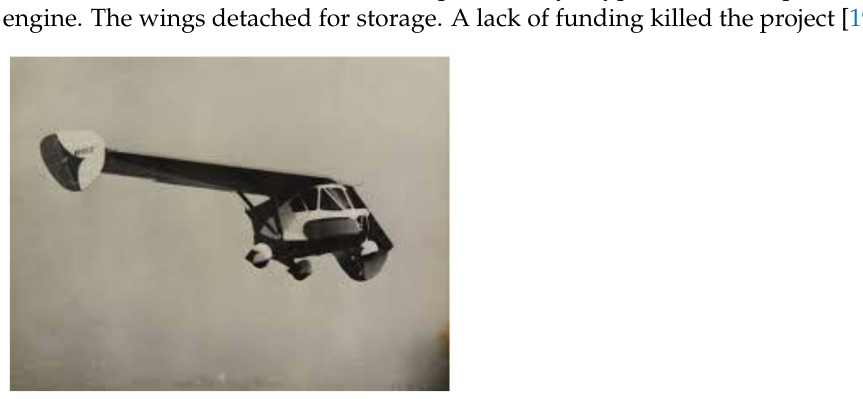
Figure 2. Waterman Arrowbile [21].